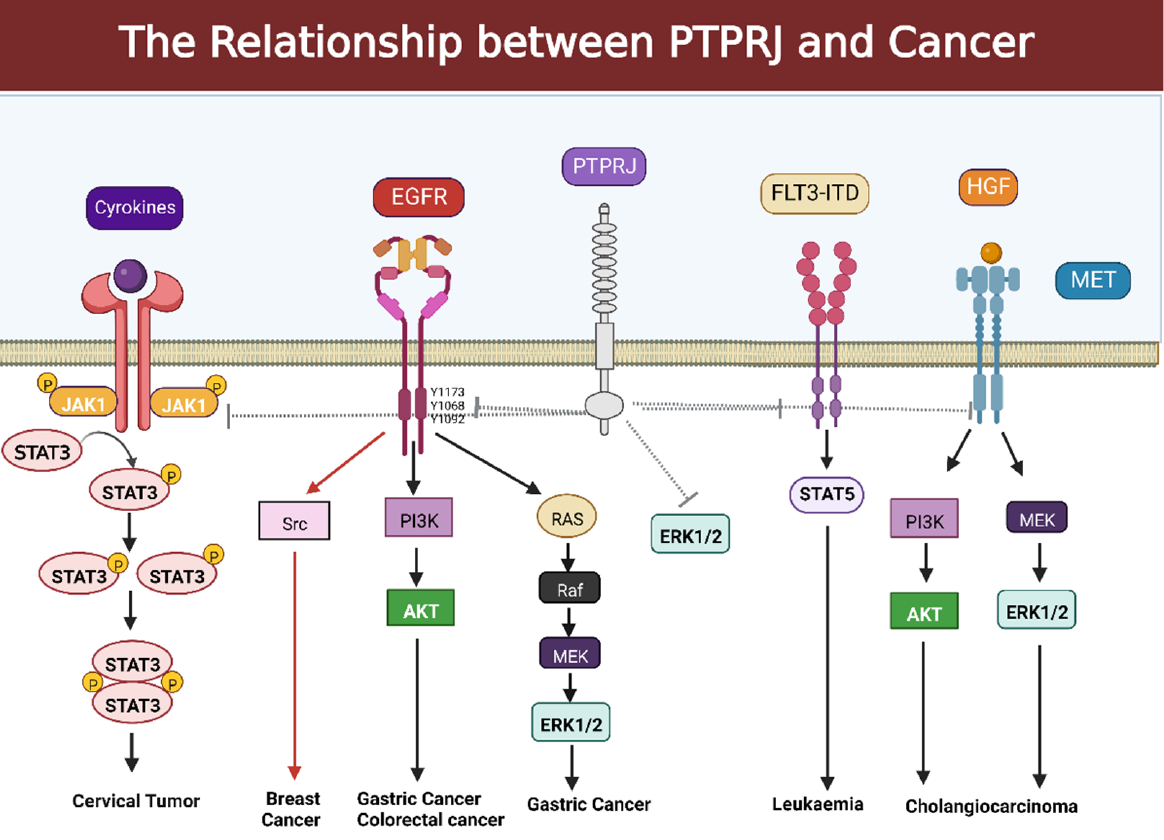
Figure 2. The relationship between PTPRJ and cancer. In cervical cancer, PTPRJ inhibits the activation of the JAK1/STAT3 pathway by decreasing the phosphorylation levels of JAK1 and STAT3. We have indicated with red arrows that PTPRJ cooperates with EGFR to increase the activation of Src-dependent signaling pathways downstream of aggressive breast cancer cells to promote tumor cell invasion and metastasis. PTPRJ negatively regulates the AKT signaling pathway in gastric and colorectal cancers. In addition, PTPRJ can also inhibit the MEK/ERK pathway in gastric cancer. In leukemia, PTPRJ inhibits FLT3 and its downstream STAT5 signaling pathway. In cholangiocarcinomas, PTPRJ has been shown to recognize MET as a substrate to inhibit PI3K/Akt and MEK/ERK downstream signaling pathways. This figure was created using BioRender